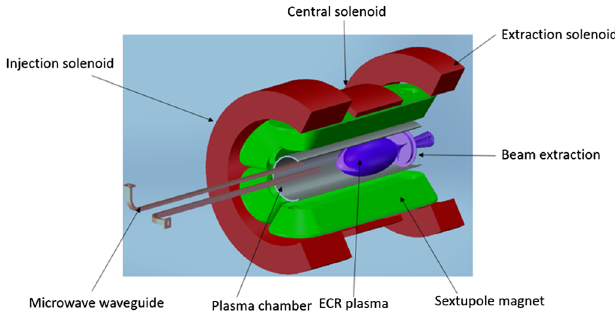
FIG. 1. Schematic view of the ECR ion source structure with minimum-B magnet